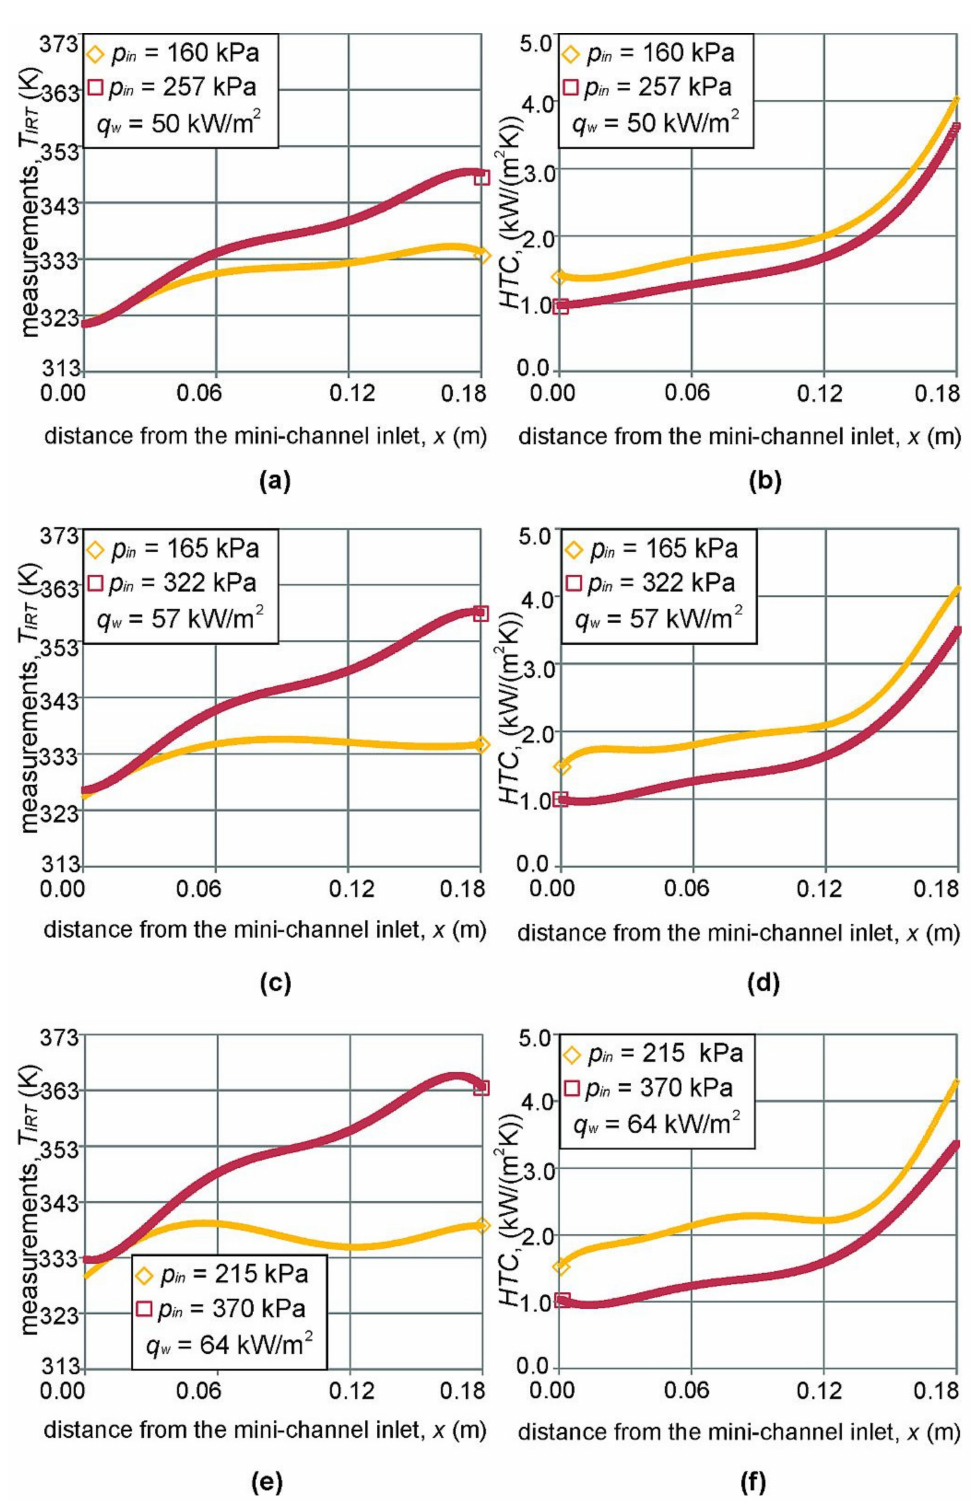
Figure 5. Plate temperature measurements using the IR camera ( a , c , e ) and heat transfer coefficient ( b , d , f ), both vs. distance from the mini-channel inlet; subcooled boiling region; various inlet pressures; vertical channel orientation (90 ◦ ); mass flux of 400 kg/(m 2 · s); modified heated plate surface (vibration-assisted laser surface texturing No. 2); HFE-649; L IRT = 180